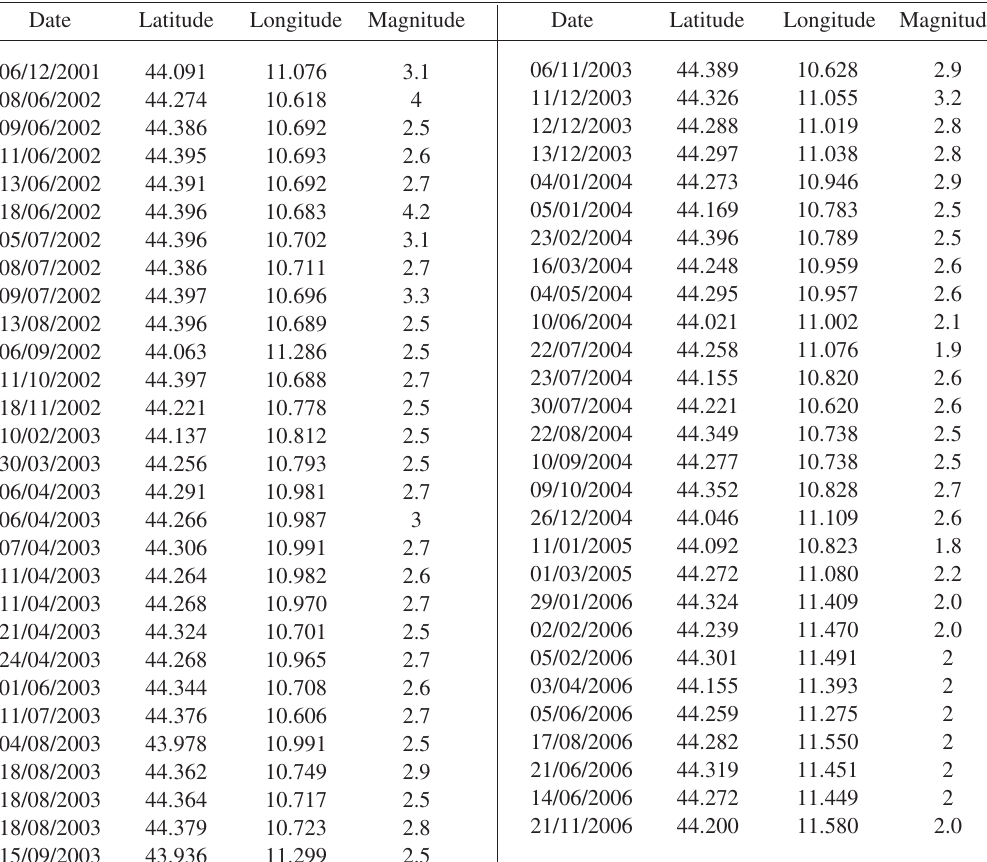
Date Latitude Longitude Magnitude